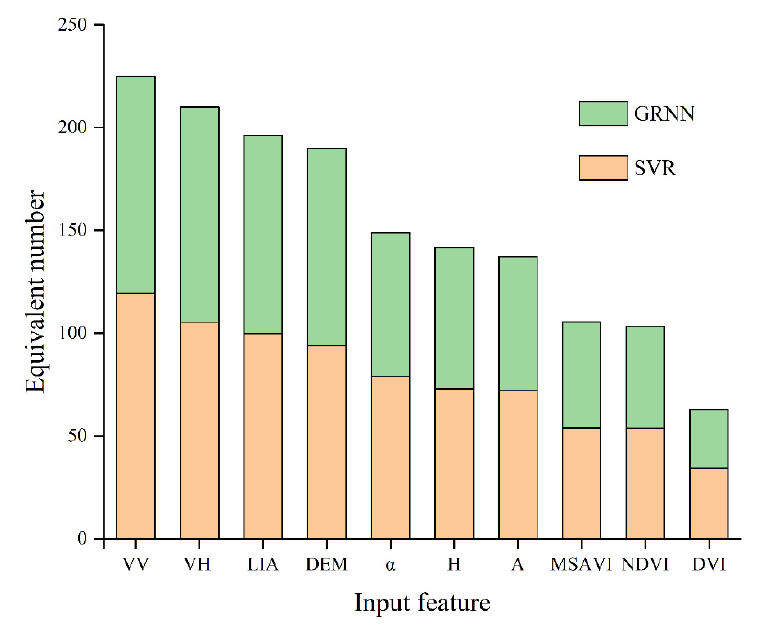
Figure 11. Equivalent number of input features.